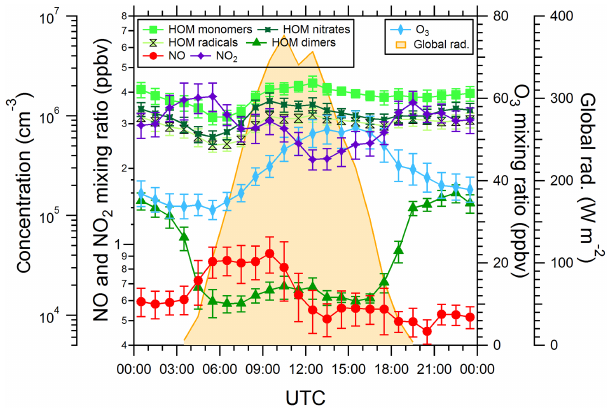
Figure 8. Diurnal profiles of the NO, NO 2 and O 3 mixing ra- tios. The signals for highly oxidized organic molecules (HOMs) are shown for some C 10 (HOM monomers, HOM nitrates and HOM radicals) and C 19 /C 20 compounds (HOM dimers), which show a distinct maximum during the night. The HOM dinitrates show a similar pattern as the other C 10 compounds and are not included in the figure. The global radiation is shown in addition. Error bars indicate 1 standard deviation for the 30min